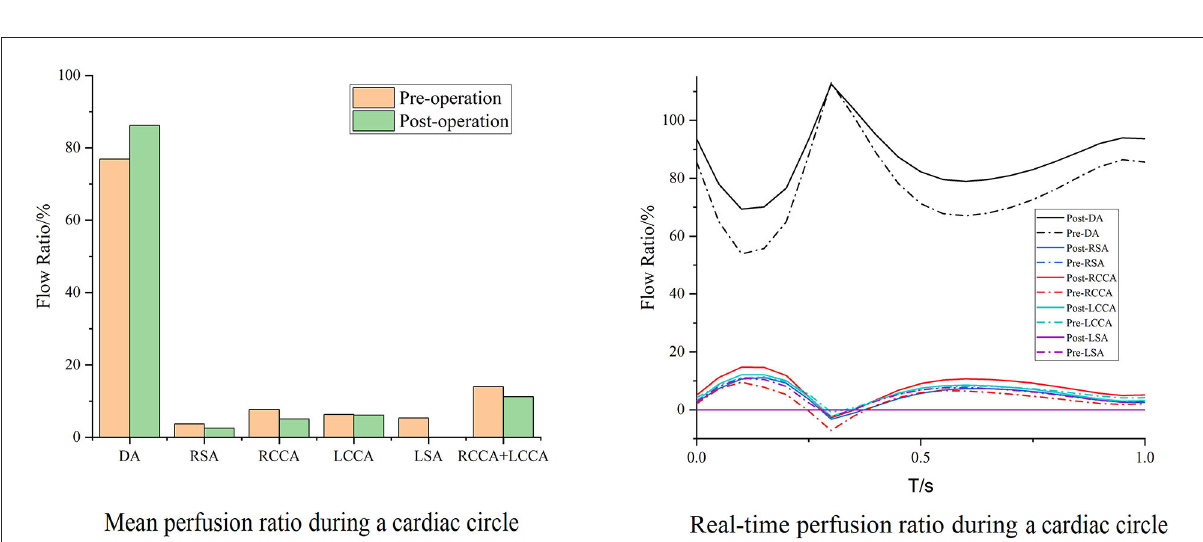
FIGURE6 Blood flow perfusion ratios of branches in Case 7. The bar graph illustrates the changes in the flow perfusion ratios in different branches. The curve figure illustrates the real-time perfusion within a cardiac cycle. Curves below the 0 level indicate backflow. DA, descending aorta; LCCA, left common carotid artery; RCCA, right common carotid artery; LSA, left subclavian artery; RSA, right subclavian